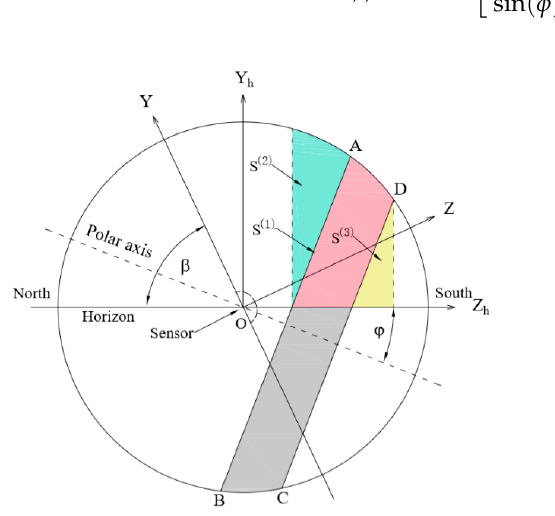
Figure 6. Schematic diagram for the integration of 𝑆 (cid:3035) while 𝑑 (cid:3039) ≥ 0 . 𝑆 ((cid:2870)) and 𝑆 ((cid:2871)) are the areas that are projected on the plane Y OZ by the spherical areas and will be used to represent the areas in the following discussions. Those spherical areas are above the left boundary section and below the right boundary section of the shadow band, respectively. the spherical areas are calculated by the second and the third terms on the right-hand side of Equation (23). (2) While 𝑑 (cid:3039) < 0 < 𝑑 (cid:3045) and 𝜙 (cid:3035),(cid:3039),(cid:3040)(cid:3036)(cid:3041) > 𝜋 − 𝛽 , shown as Figure 7, the axis Y is between the points A and D. The Equation (5) is written as 𝑆 = (cid:3505) (cid:3505) (cid:3035) in which 𝛼 = sin (cid:2879)(cid:2869) [− cot(𝜙) tan(𝛽)] (cid:3035),(cid:3036),(cid:2869)